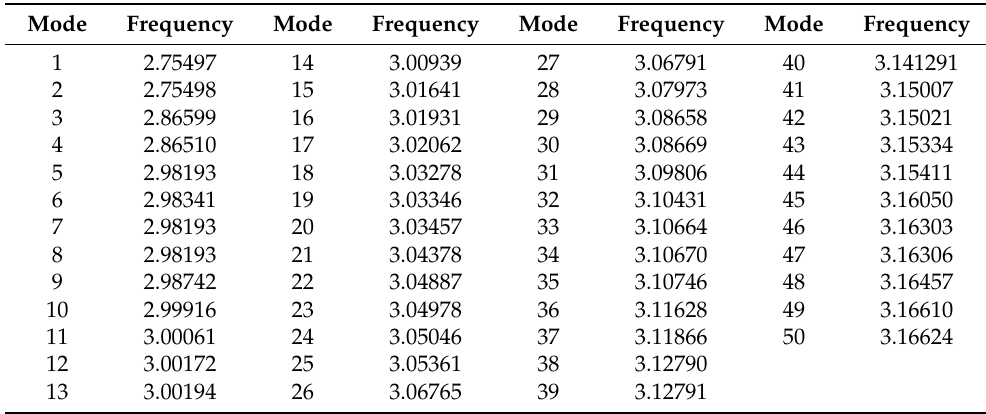
Table A1. Natural frequency obtained from the modal analysis